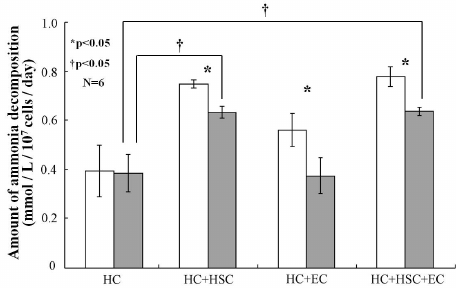
Fig. 7 Effects of L-NAME on ammonia decomposition under flow load. L-NAME decreased ammonia decomposition in the HC+HSC, HC+EC and HC+HSC+EC models. Data are presented as the means ± SD. White columns, no L-NAME; gray columns, +L-NAME. *p<0.05 versus models containing no L-NAME; †p < 0.05 versus HC model of